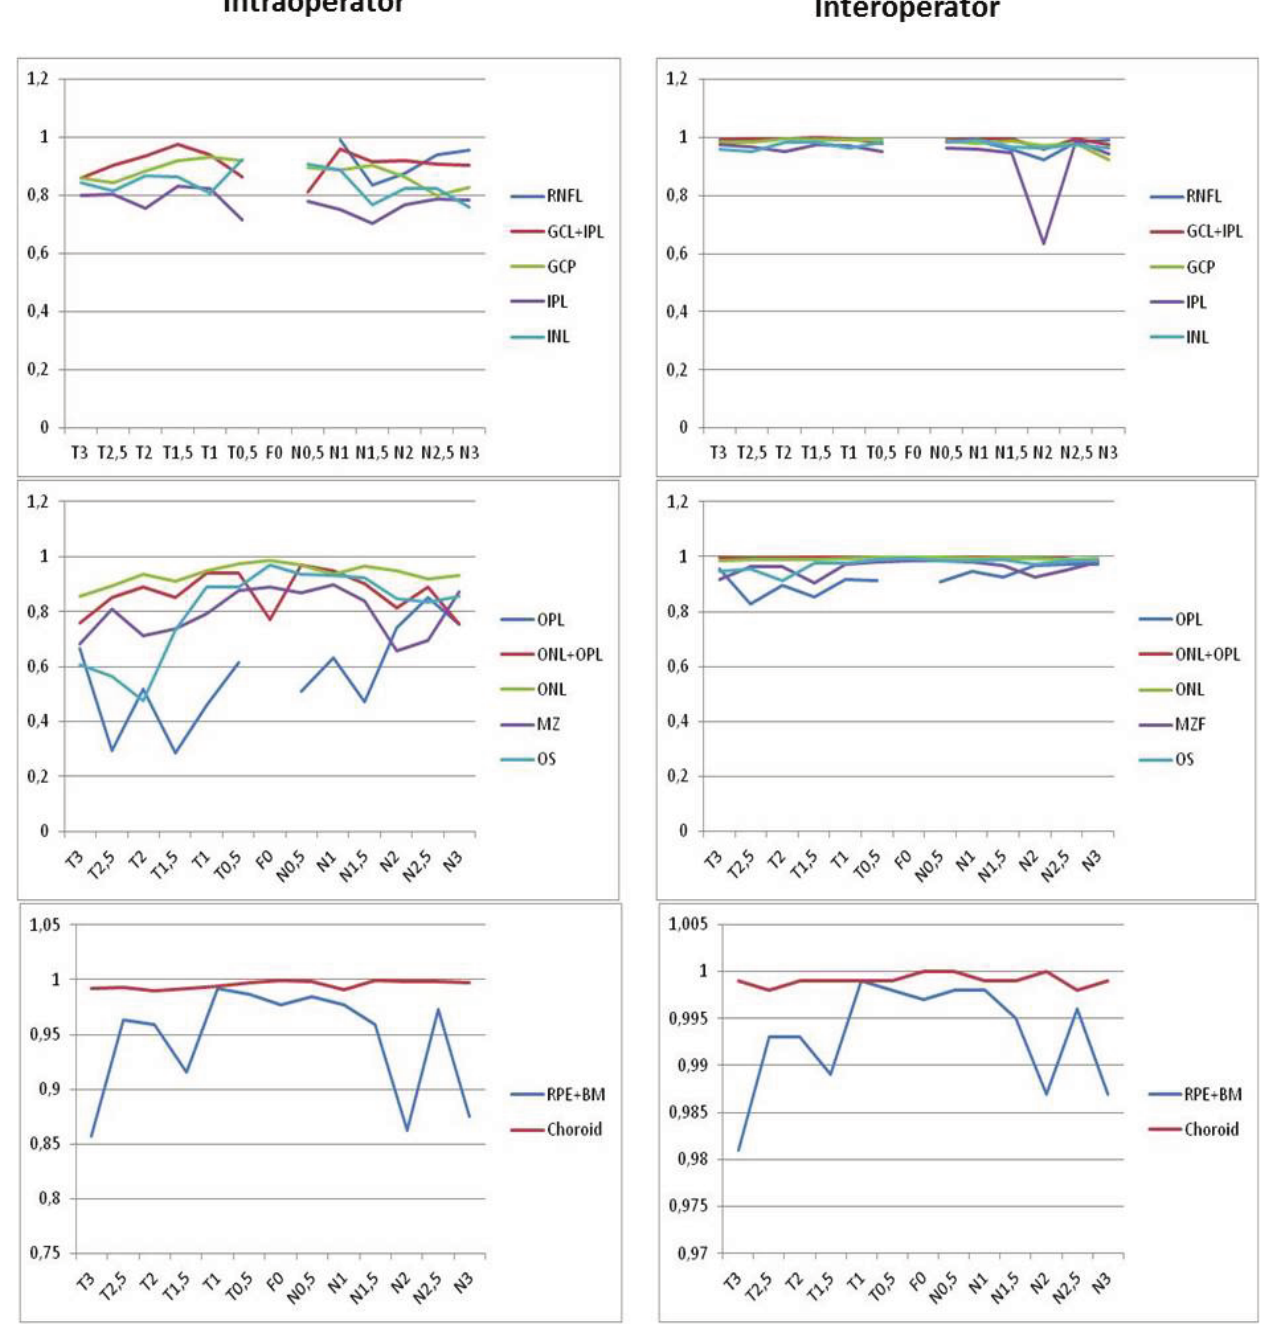
Figure 4. (A) Intra-operator inner layers. (B) Intra-operator outer layers. (C) Intra-operator RPE/MB complex and choroid. (D) Inter- operator inner layers. (E) Inter-operator outer layers. (F) Inter-operator RPE/BM complex and Choroid. T3, 3 mm temporal; T2.5, 2.5 mm temporal; T2, 2 mm temporal; T1.5, 1.5 mm temporal; T1, 1 mm time; F0, foveal thickness; N0.5, 0.5 mm nasal; N1, nasal 1 mm; N1.5, 1.5 mm nasal; nasal N2, 2 mm; N2.5, 2.5 mm nasal; N3, 3 mm